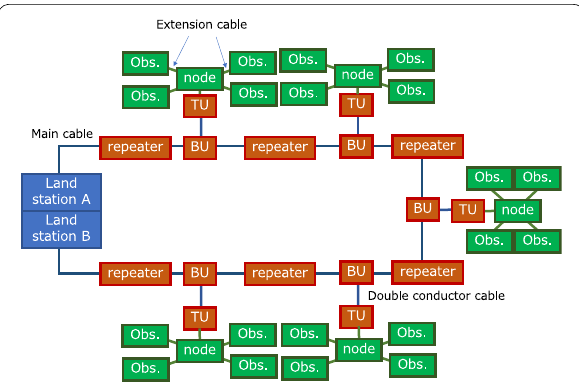
Fig. 7 Schematic outline of the DONET system. BU, TU, and Obs indicate branching units, terminal units, and observatories, respectively